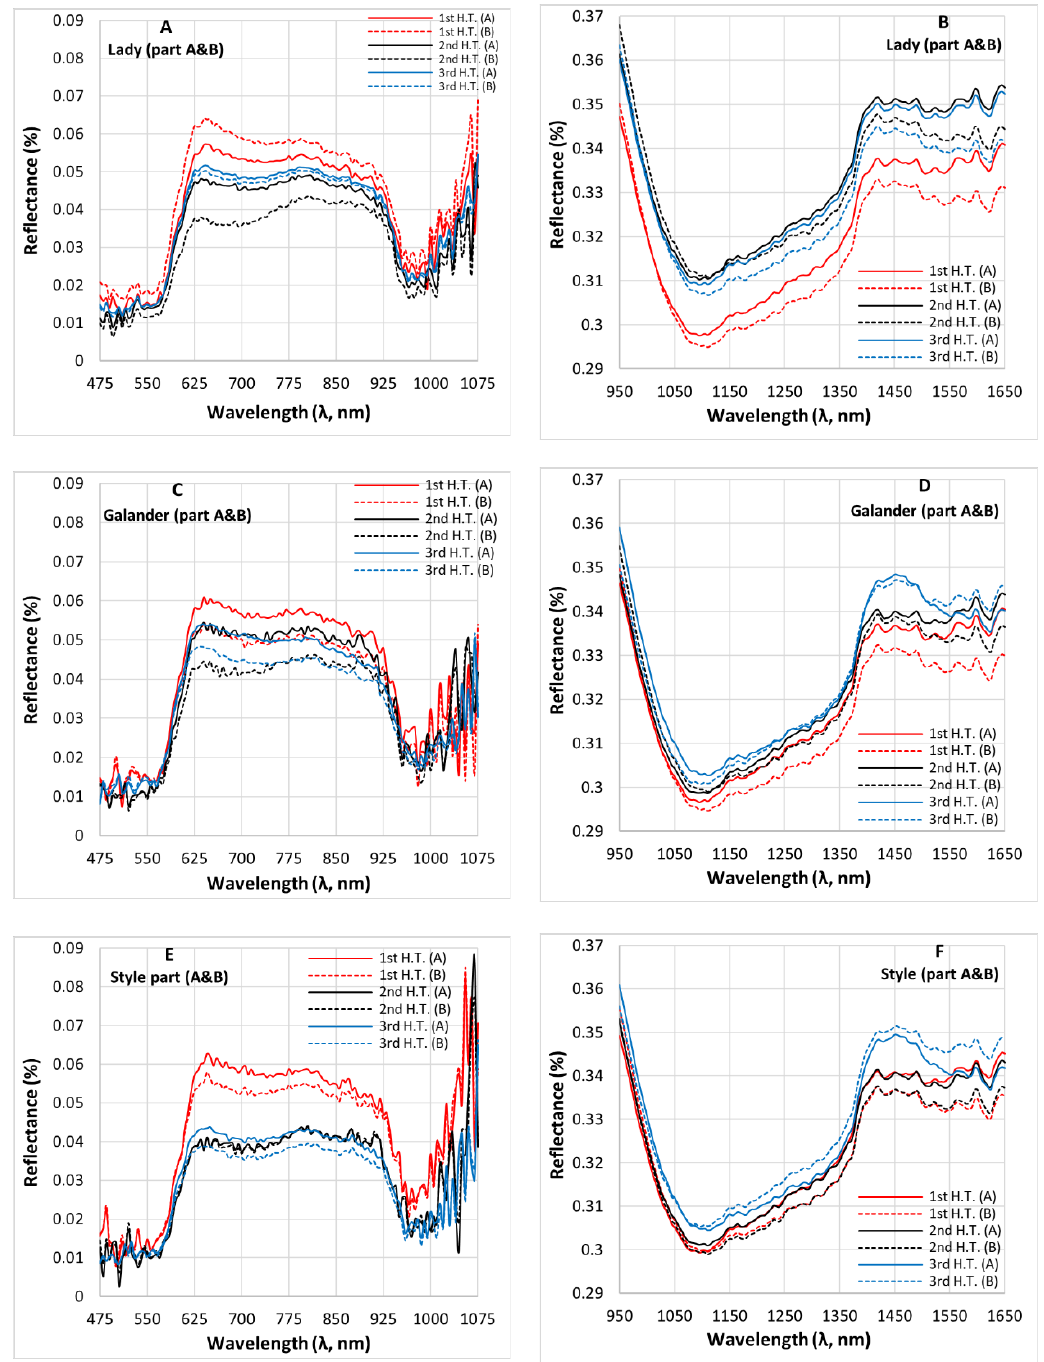
Figure 3. Typical reflectance spectra of Lady, Galander, and Style parts ( A , B ) at first, second, and third HT by a spectroradiometer ( A , C , E ) (475:1075 nm) and NIRS ( B , D , F ) (950:1650 nm). It shows that the Vis-NIR spectra are quite similar, with some distinctive peaks and valleys revealing the quality attributes of the tested samples. Lady, Galander, and Style, three spectral groups, show wide differences in the Vis range 475–700 nm, most likely due